Question: Describe this figure in one sentence.
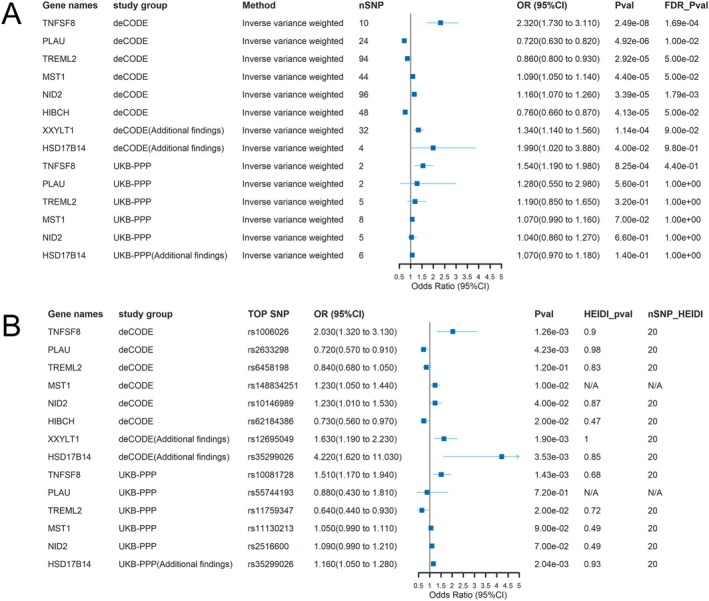
Answer: (A) Results of MR of 8 plasma proteins. OR, odds ratio; nsnp, number of Single‐nucleotide polymorphism; 95% CI, 95% confidence interval; FDR, false discovery rate; nSNP, number of SNPs. (B) Results of SMR of 8 plasma proteins. OR, odds ratio; HEIDI, HEIDI test; nSNP_HEIDI, Number of SNPs used to calculate HEIDI TEST; SNP, single‐nucleotide polymorphism.